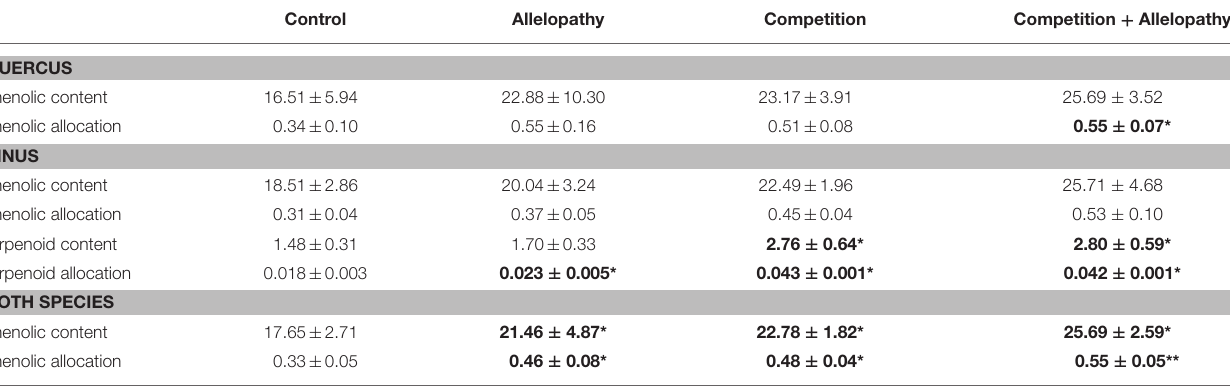
TABLE 2 | Species-specific ( Quercus and Pinus separately) and overall (mean of both species) effects of treatments on induced-secondary